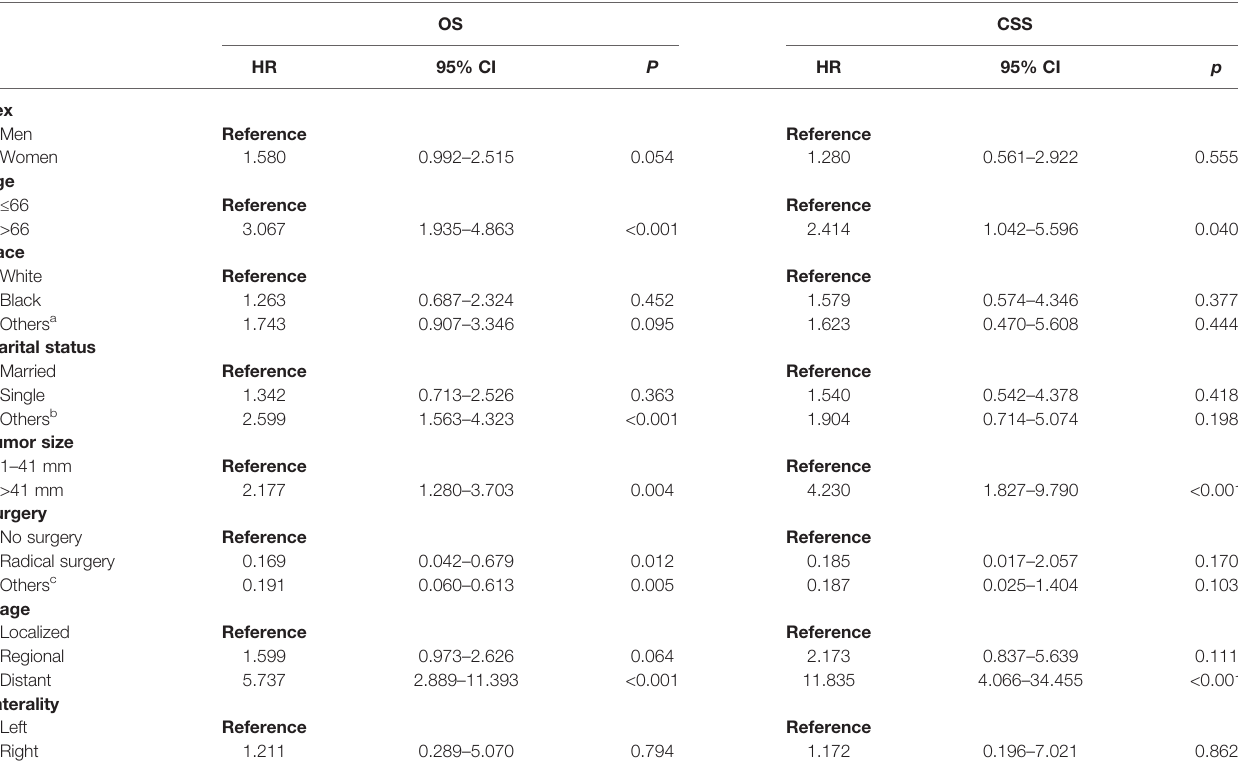
TABLE 2 | Univariate Cox regression analysis of OS and CSS in patients with parathyroid cancer in the training set. OS CSS HR 95%